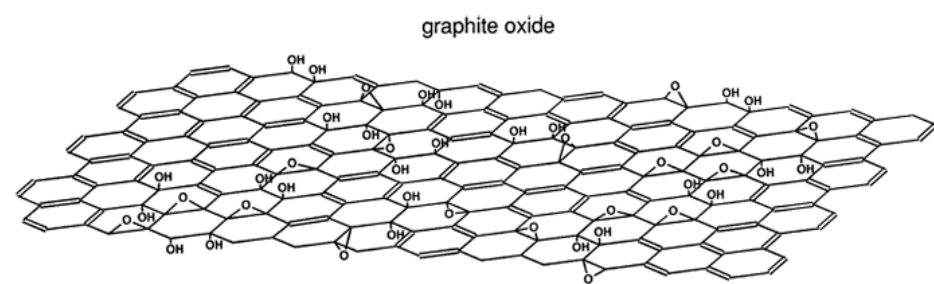
Figure 2. Chemical structure of GO. Reprinted with permission from [40]. Copyright@ Elsevier.